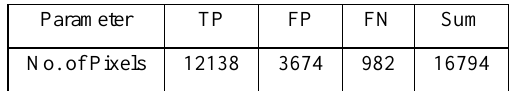
Table1. Quantitative evaluation of vegetation